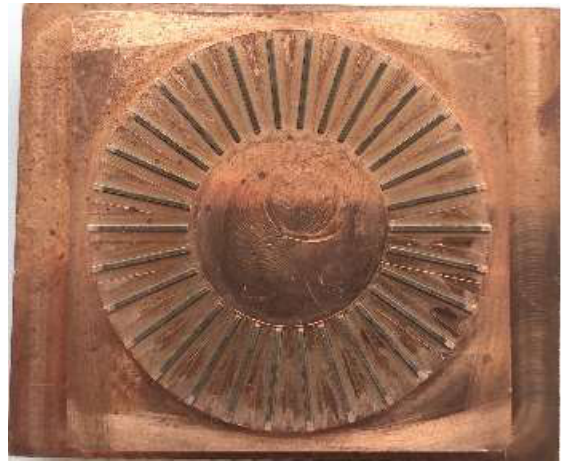
Figure 1. Electrode for preparing texture.